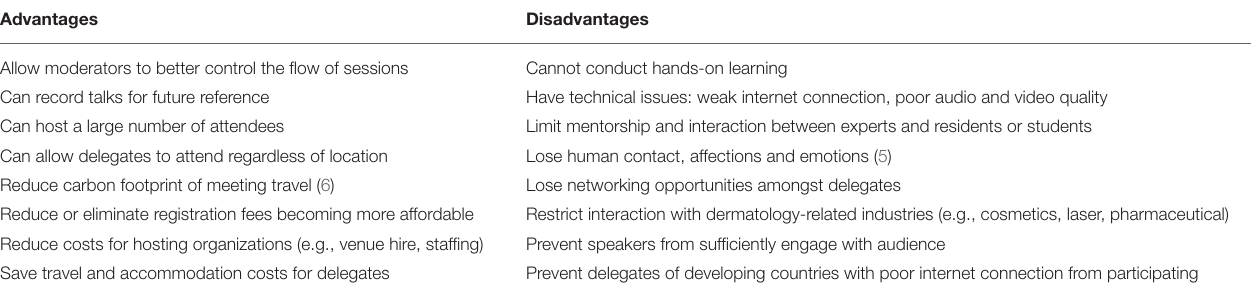
TABLE 2 | Advantages and disadvantages of running conferences